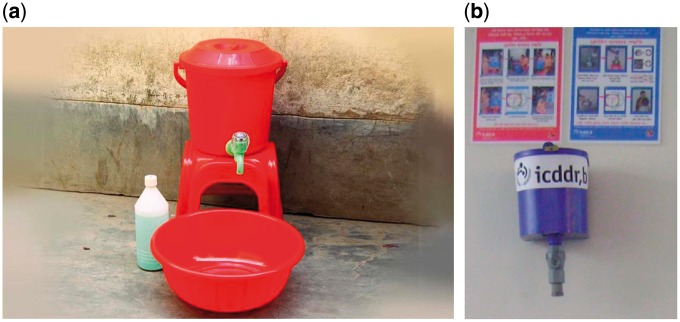
Hand-washing station [includes bucket with tap, bowl, and soapy water (a) and point of use water treatment hardware including chlorine dispenser and instruction sheets (b)].